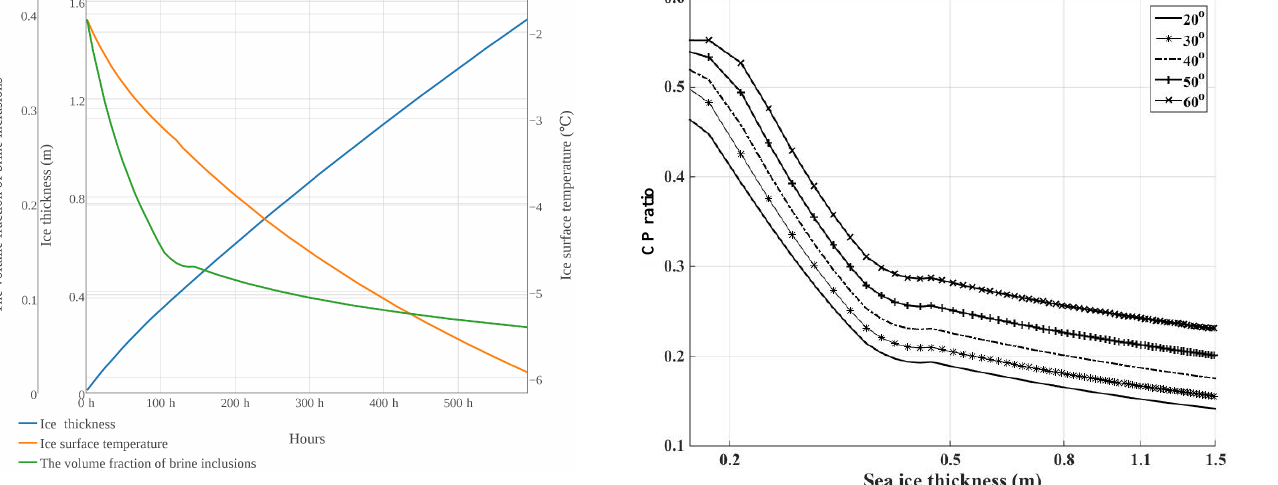
Figure 5. The relationship between the CP ratio and ice thickness at different incidence angles for C-band radar ( x axis on a log scale). The incidence angle varies from 20 to 60 ◦ . The small-scale rough- ness parameters are set to s = 0.11cm and l = 0.54cm (case 3), the standard deviation of the surface slope σ =